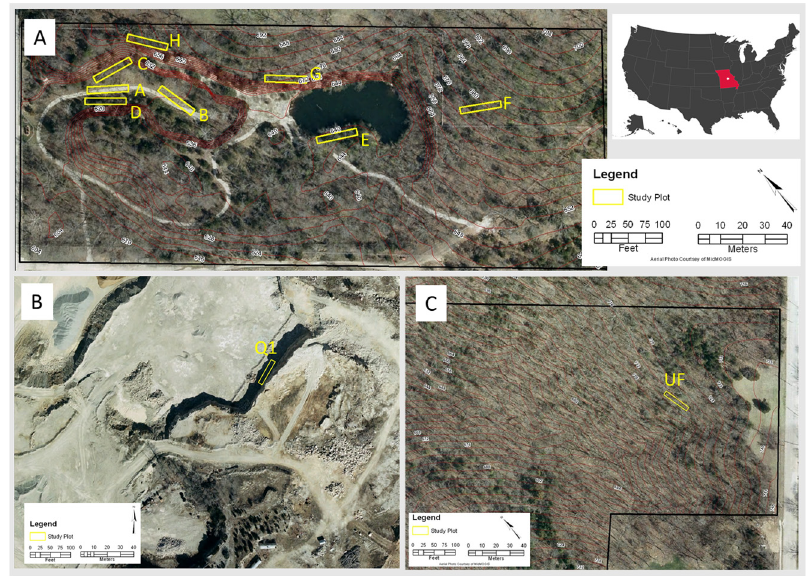
Figure 1. Locations of 20-m × 3-m study plots in ( A ) a quarry abandoned 70 years prior to the study (site Q70; with eight study plots labeled A-H), ( B ) a reference quarry that ceased operations 1 year prior to the study (site Q1 with the study plot also labeled Q1), and ( C ) an urban forest reference site that was never quarried and with trees over 100 years old (site UF with the study plot also labeled UF). The solid black lines represent property boundaries that are fenced ( A ) or unfenced ( C ). All study sites are within city limits of Jefferson City, Missouri, USA (inset